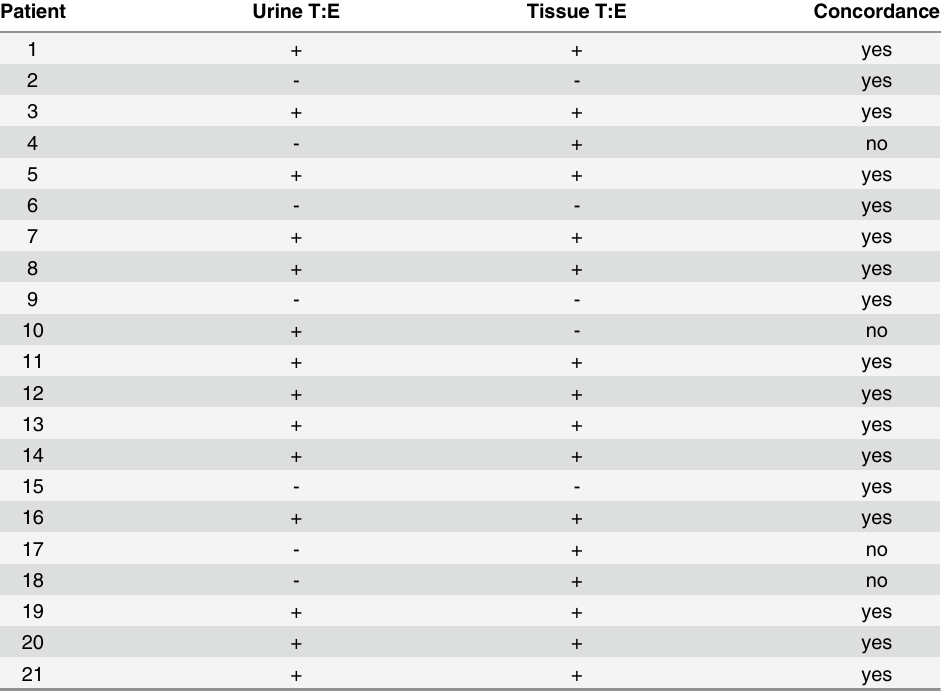
Table 1. The Detection of TMPRSS2:ERG in Urinary EVs versus Corresponding Prostatectomy Tissue from the same patients. Patient Urine T:E Tissue